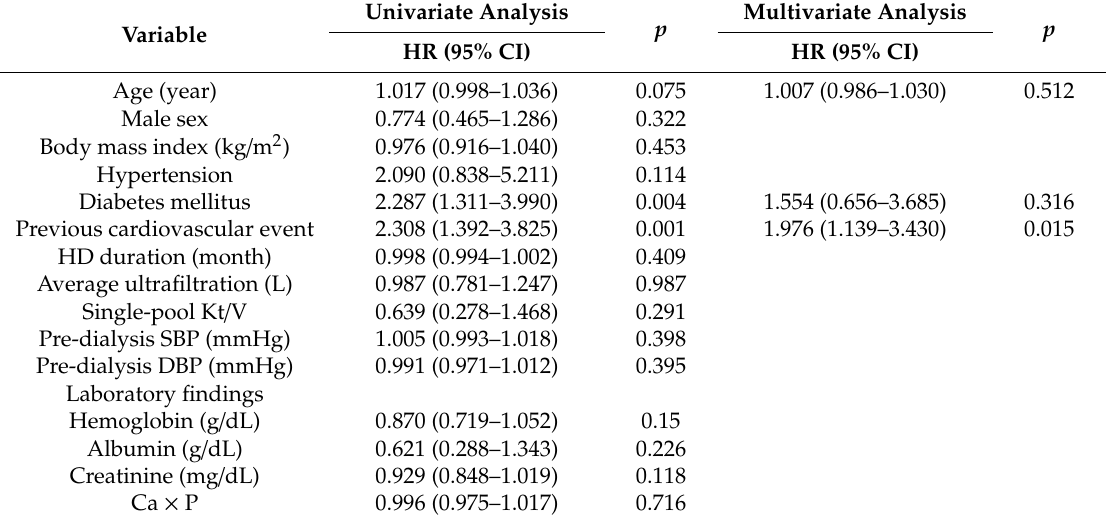
Table 4. Predictors of cardiovascular events in univariate and multivariate Cox regression analyses.